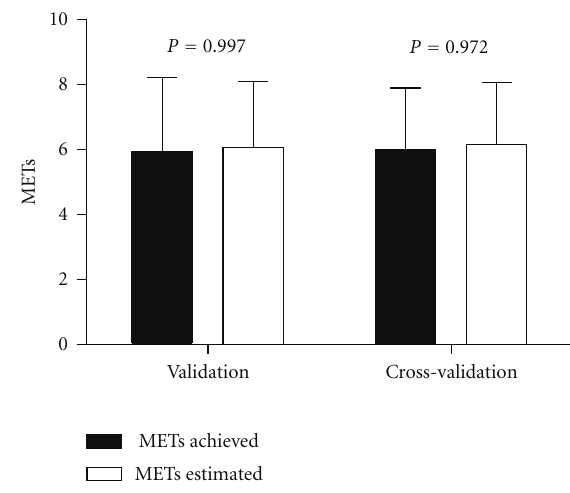
Figure 1: Predicted and actual CRF (MET peak ; mean ± SD) in both validation and cross-validation groups.